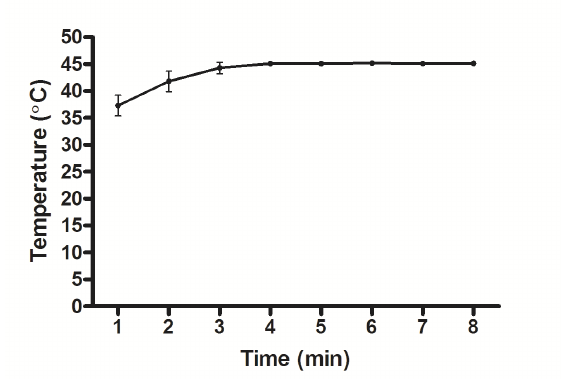
FIGURE 2 - Time evolution (temperature) of continuous thermal application by ultrasound device.